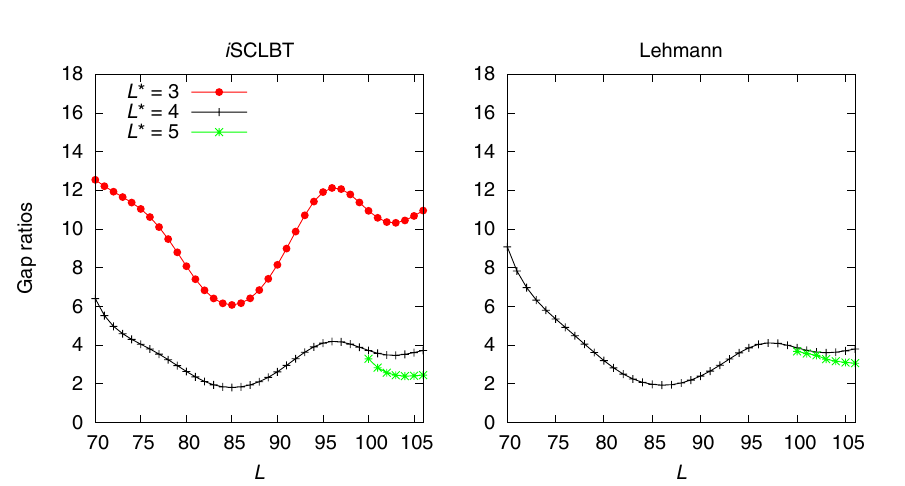
Figure 5. Comparison of second excited state lower bound gap ratios calculated by the i SCLBT and Lehmann methods for the Hubbard model.The red line indicates i SCLBT calculation at L ∗ = 3 and the gray and green lines indicate results at L ∗ = 4 and L ∗ = 5 , respectively, for both